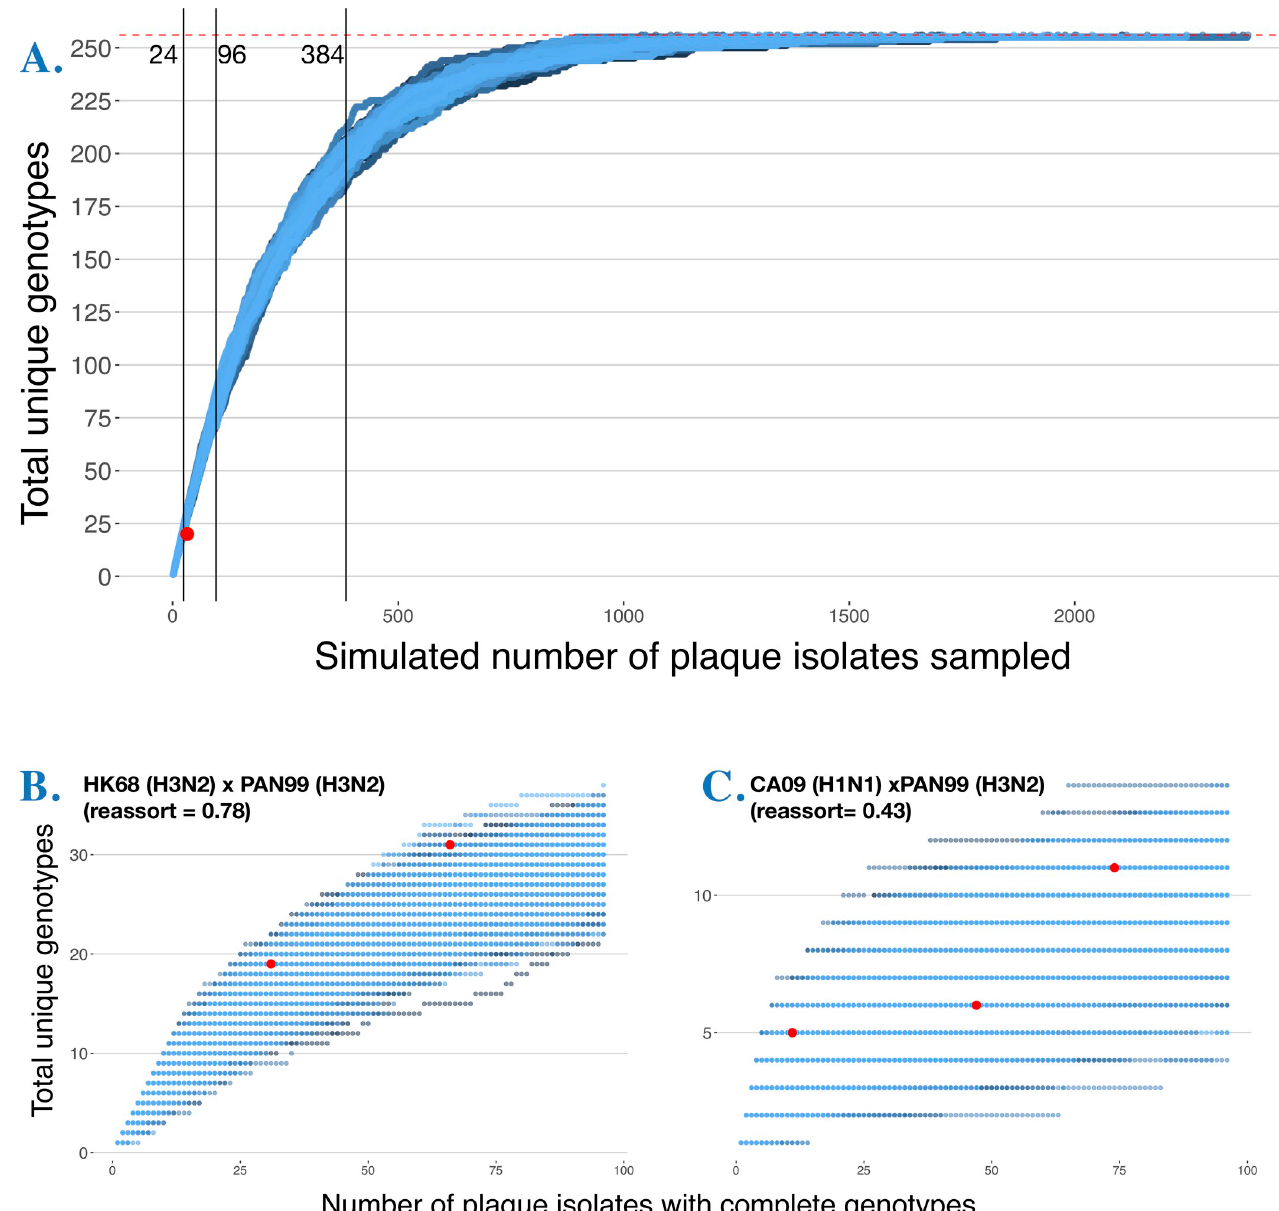
Fig 10. A large sample of progeny plaque isolates is essential to capture all potential genotypes generated by coinfections. A. Simulated number of progeny plaque isolates (x-axis) needed to reach 256 genotypes under free reassortment (horizontal red dashed line). Vertical gray lines denote typical sample sizes for molecular biology studies (24, 96, 384). B. Replicate coinfection (n = 2, left; n = 3 right) experiments were used as starting data to generate a sample accumulation curve similar to A, but sampling empirical data. Number of unique genotypes found in individual replicate experiments are shown in red, to depict the effect of reduced sample sizes in capturing genotype richness of experimental